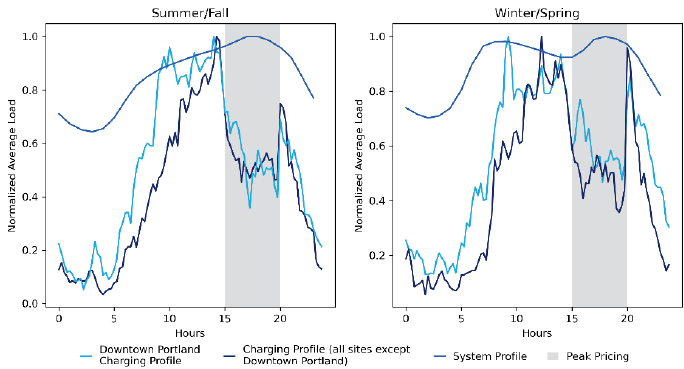
Figure 9. Normalized system load shape verses the normalized charging profile.